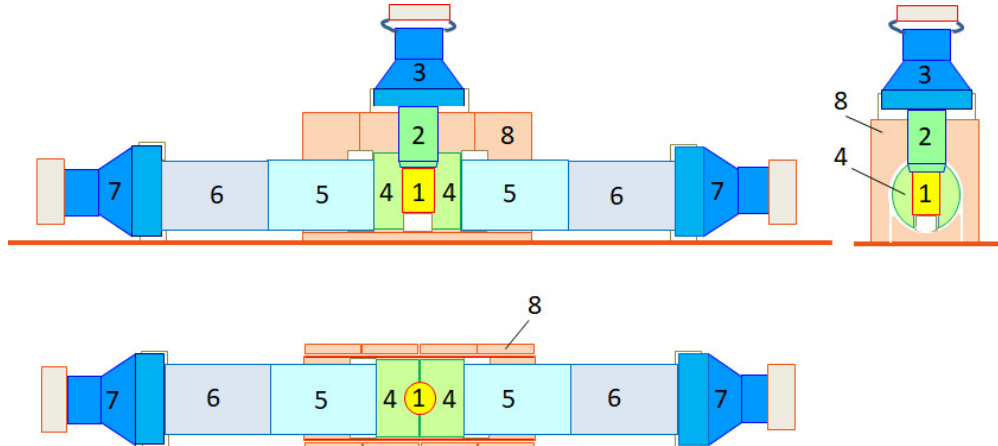
Figure 2. Schematic of the experimental set-up with the 106 CdWO 4 scintillation detector. 106 CdWO 4 crystal scintillator (1) is viewed through PbWO 4 light-guide (2) by photo-multiplier tube (3).